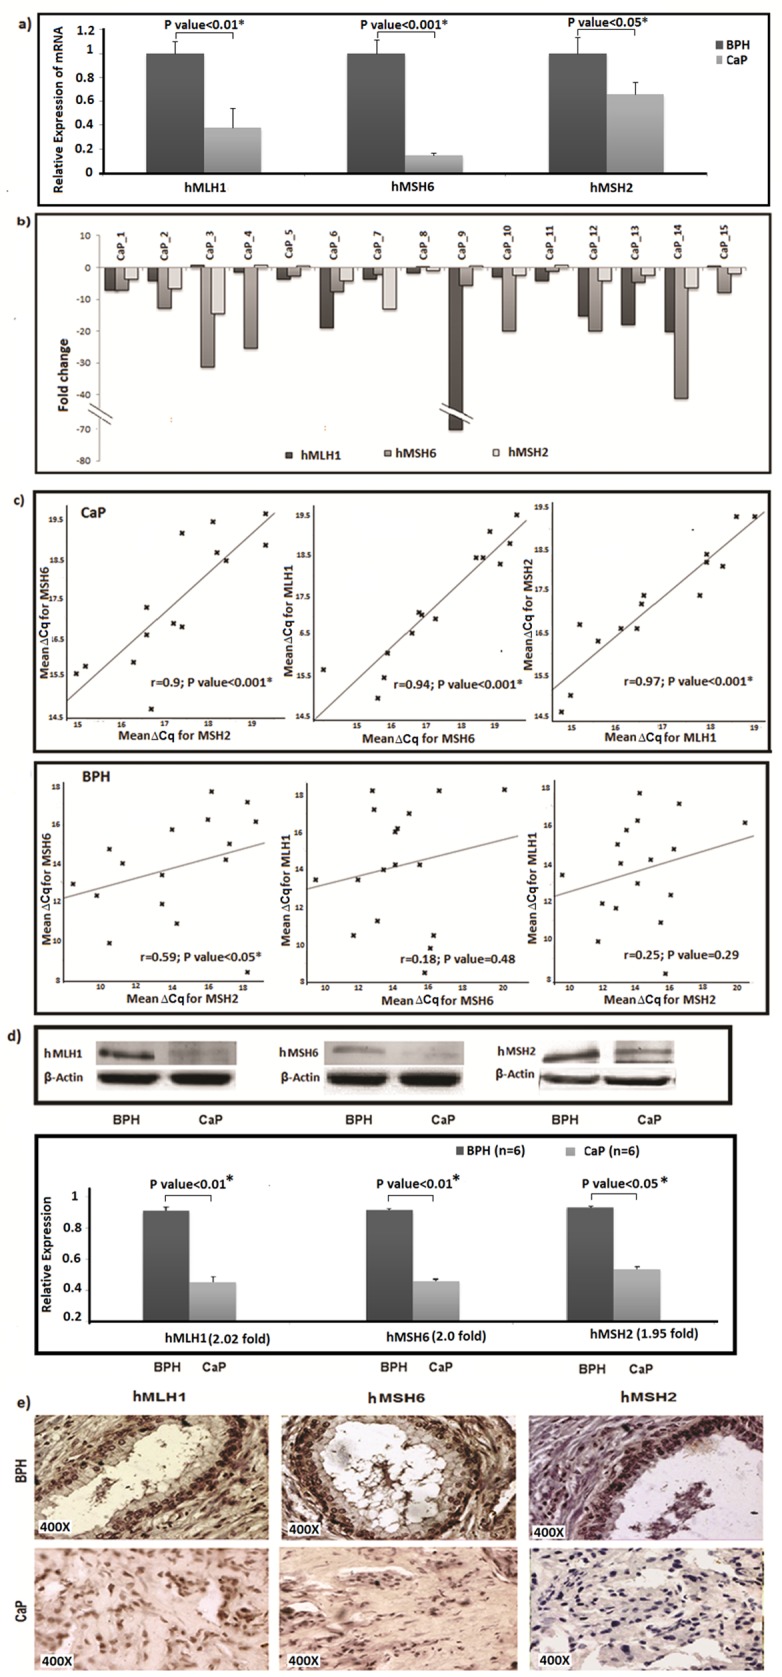
MMR gene expression in cancer and benign hyperplasia of prostate glands.(a) Bar diagram showing decreased expression of transcripts of hMLH1, hMSH6 and hMSH2 genes in prostate cancer tissues compared to that of BPH patients. 18S rRNA was used as endogenous control. * indicates P <0.05. (b) Fold differences of hMLH1, hMSH6 and hMSH2 expression in each of 15 cancer tissue specimens with respect to population mean of ∆Cq estimate of the said gene in BPH tissues. (c) Upper panel: Plots showing correlation between transcript levels of hMSH6 and hMSH2, hMSH6 and hMLH1 and hMSH2 and hMLH1 in prostate cancer. Lower panel: Plots showing correlation between transcript levels of hMSH6 and hMSH2, hMSH6 and hMLH1 and hMSH2 and hMLH1 in BPH. Pearson’s correlation coefficient (r) and P values are indicated for each test. * indicates P <0.05. (d) Upper panel: Representative result of Western blot for MMR proteins in cancer and benign tissue of prostate. β-Actin acted as endogenous control. Lower panel: Bar diagram showing difference in expression of hMLH1, hMSH6 and hMSH2 at the protein level between BPH and prostate cancer tissue samples. Fold changes and statistical significance are indicated. * indicates P <0.05 and n indicates the number of samples. (e) Photomicrograph of representative prostate archival specimens immune-stained with antibodies against hMLH1, hMSH6 and hMSH2 at 400x magnification showing decreased expression of the MMR genes in prostate cancer tissues compared to benign hyperplastic tissues.